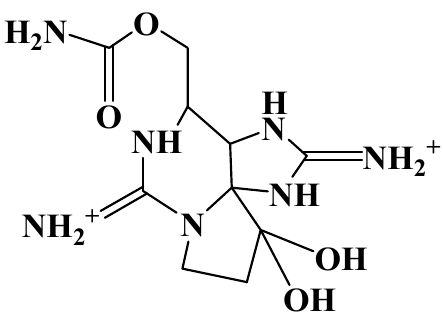
Figure 1 . Molecular structure of